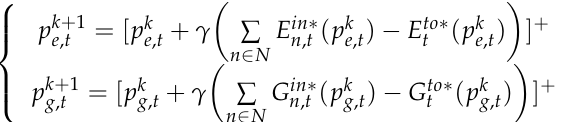
Algorithm 1: An iterative algorithm executed by the EP and SEHOs